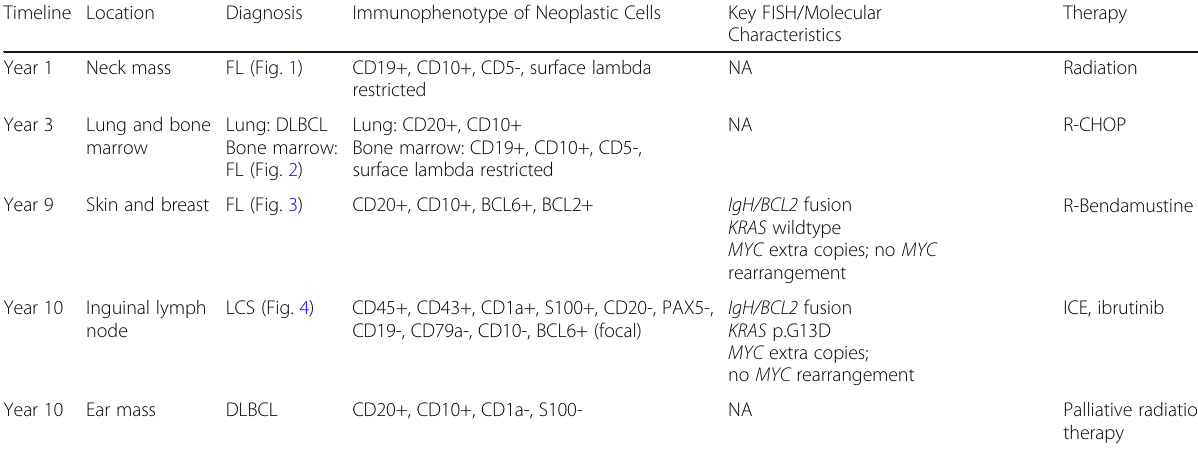
Table 1 Summary of Clinical, Pathologic and Genetic Characteristics of Tumors Timeline